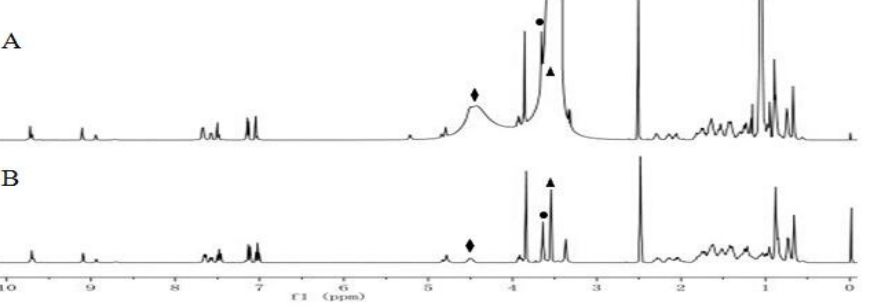
Figure 6. Portion of 1 H NMR spectra of compound 7a in DMSO-d 6 in the presence of increasing amount of Ag + : ( A ) +1 equiv; ( B ) +0 equiv; ( , NCH; , 12 α -COOCH 3 ; • , ArOCH 3 ).